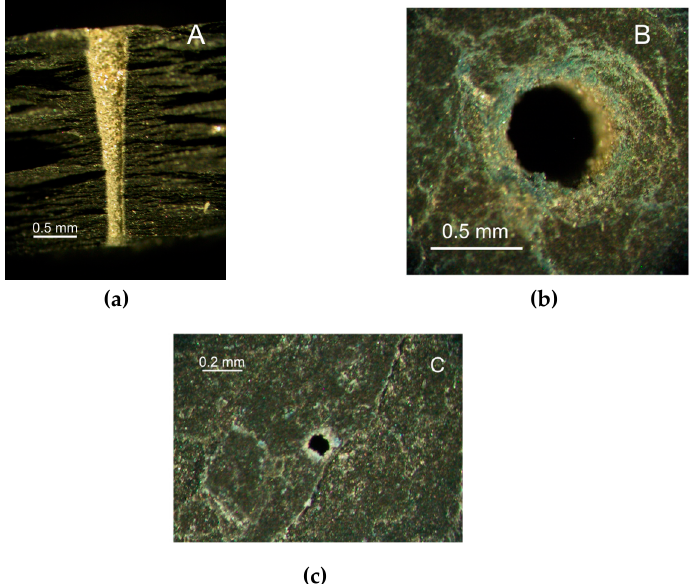
Figure 1. Optical micrographs of the ( a ) cross-section, ( b ) entrance side, and ( c ) exit side of a hole produced with the CO 2 laser (Processing parameters: P = 300 W, S = 3 mm, F = 2000 Hz, N = 45, C = 50%, FP = − 1 mm, B = 3 mm, G = 6 bar).